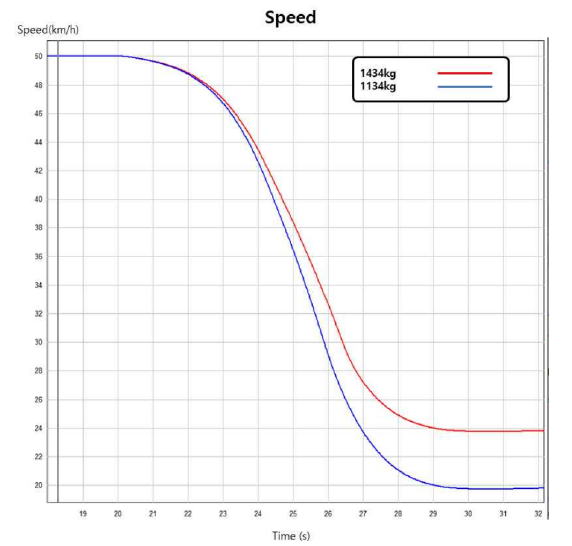
Figure 25. Maximum target speed comparison according to vehicle weight. Corresponding to the vehicle weight changing from 1134 to 1434 kg, the maximum target speed was adjusted from 20 to 24 km/h.